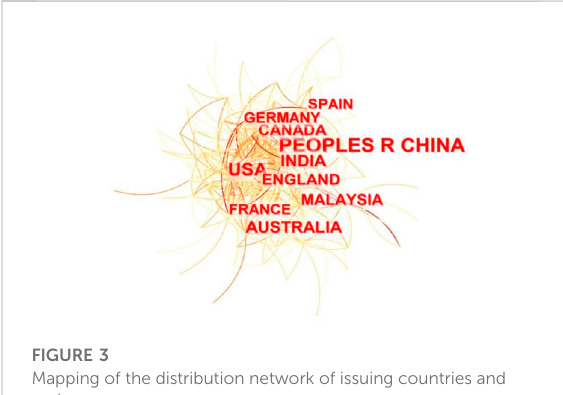
FIGURE 3 Mapping of the distribution network of issuing countries and regions.